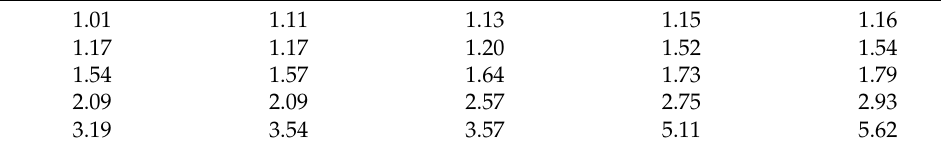
Table 6. Precipitation (in inches) at Jug Bridge, Maryland.